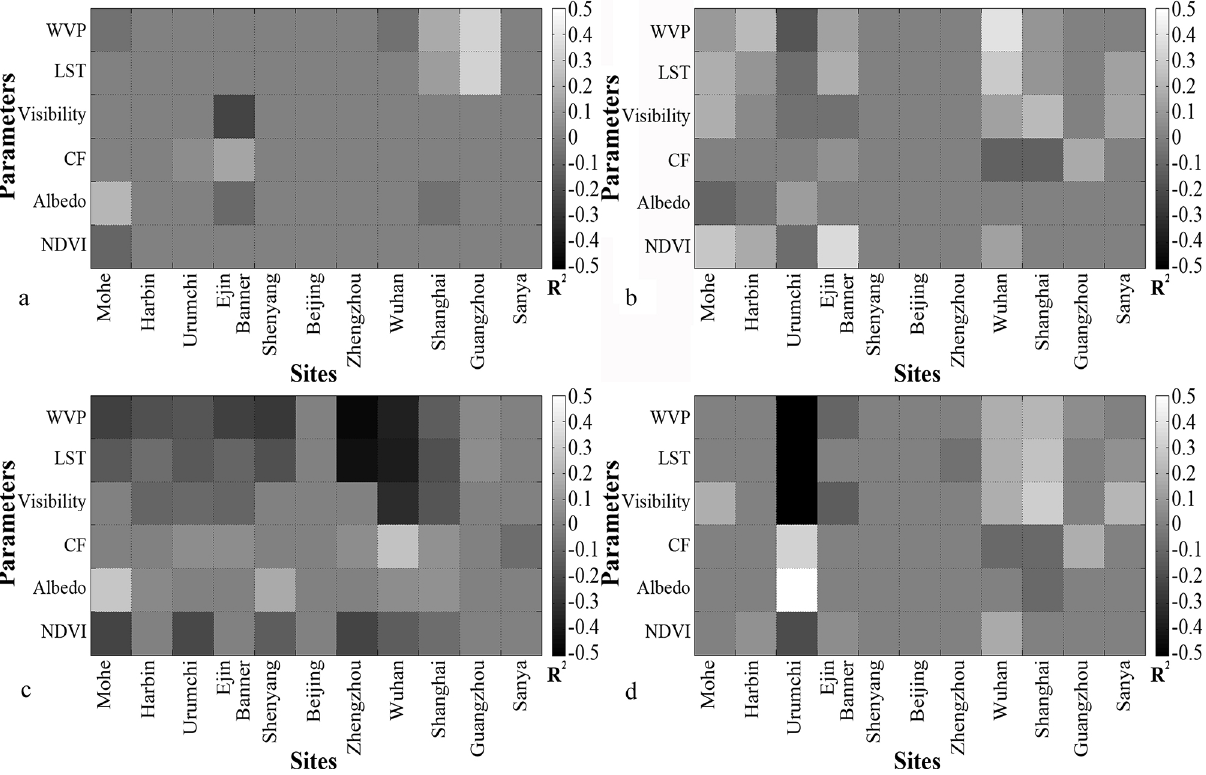
Figure 9. Correlation coefficients (R 2 ) between environmental parameters and errors in NSW and NLW for CERES and SRB at 11 level-1